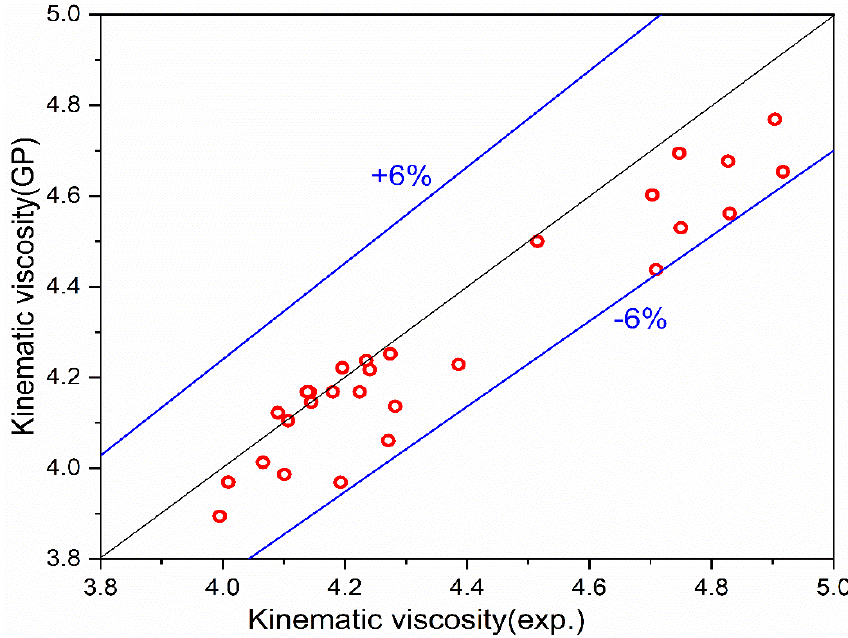
Figure 6. Experimental versus genetic programming based symbolic regression predicted kinematic viscosity.